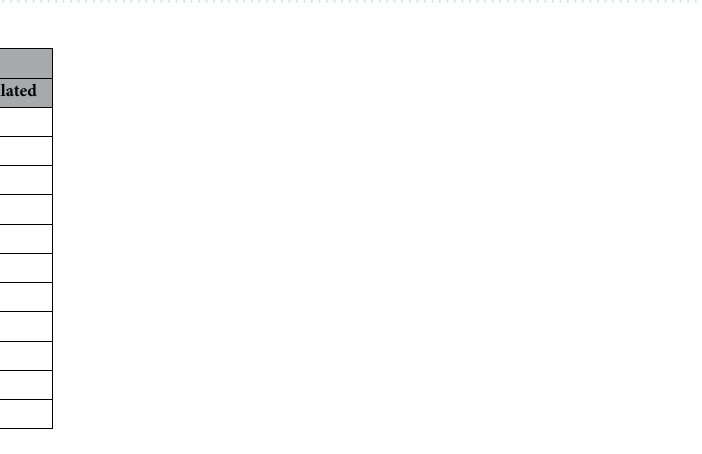
Figure 15. The evolution of solar radiation over future years (2020–2030).